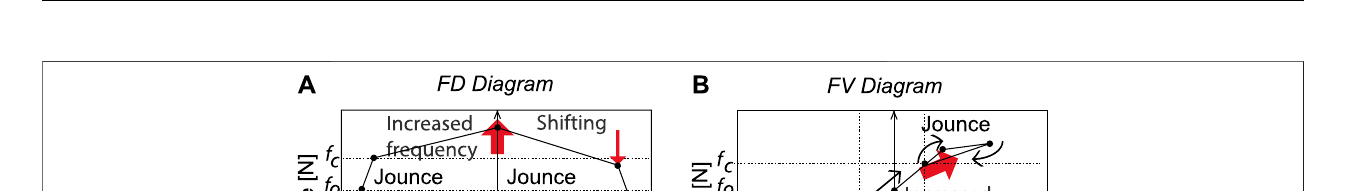
FIGURE 5 | Characteristic diagrams at ω M , Type-1 .